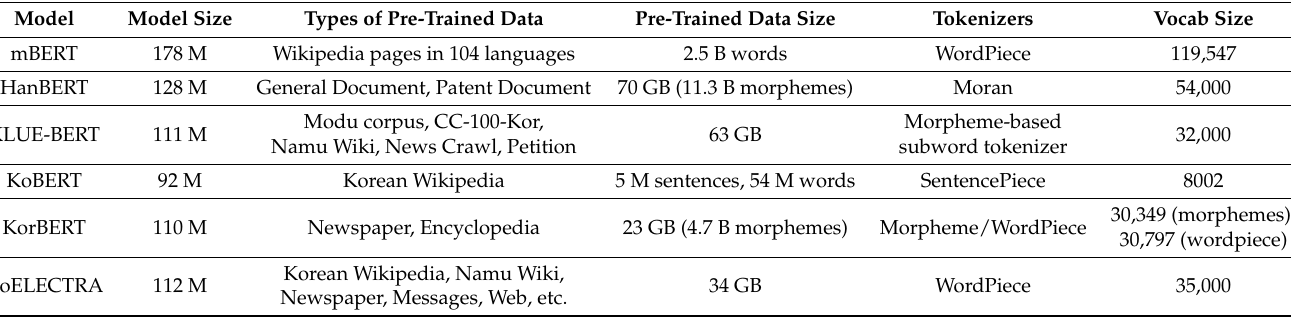
Table 1. Comparison of different language models.